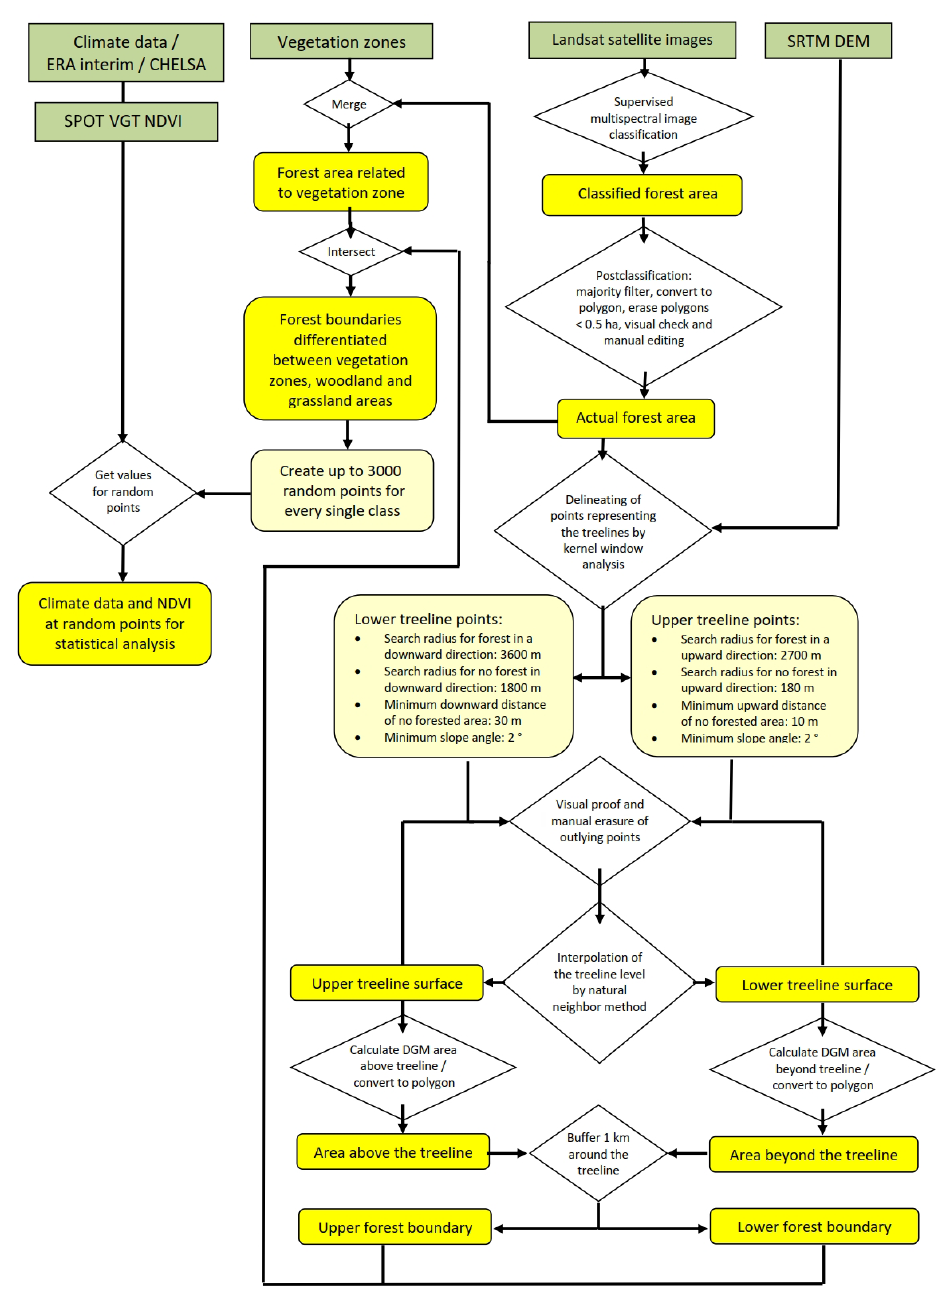
Figure 2. Processing workflow for treeline delineation, NDVI and climate